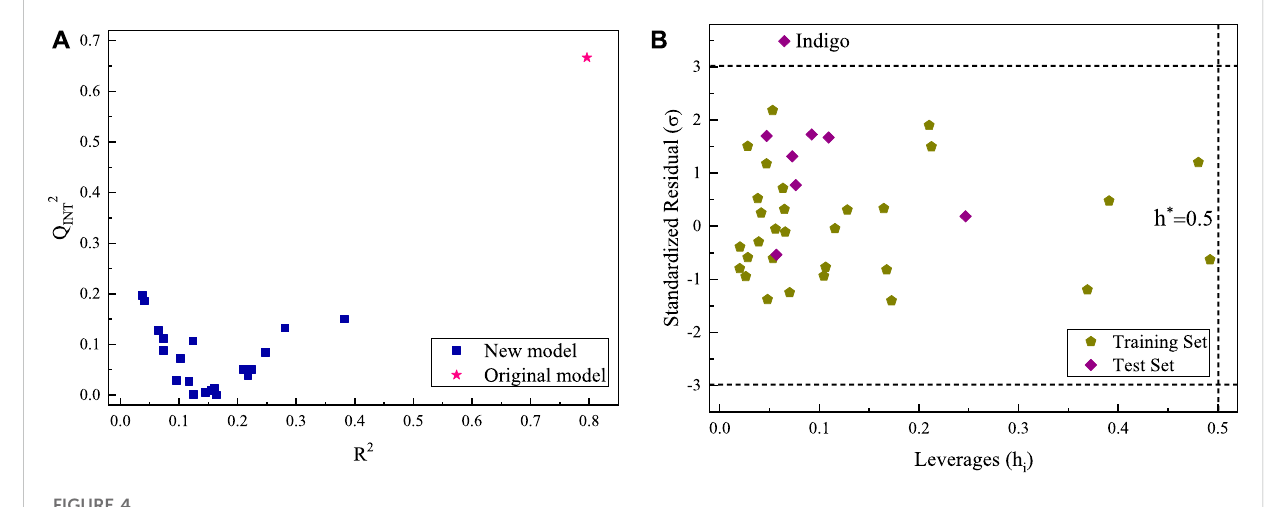
FIGURE 4 Y-randomization (A) and APD test (B) of the optimal QSAR model for R pre by AlCl 3 under alkaline conditions.